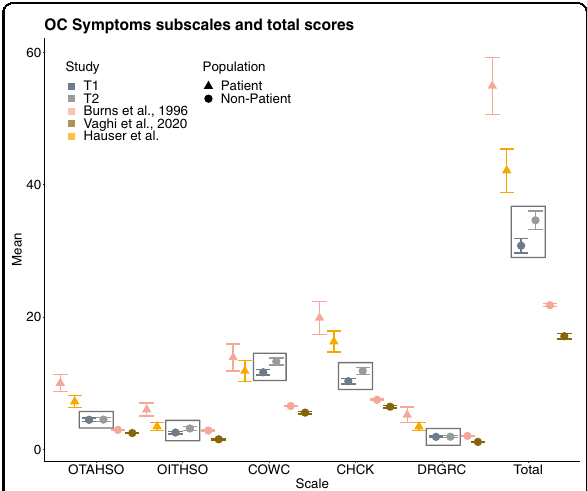
Fig. 2 Average OC symptoms sub- and total scores of the Padua Inventory Washington State University Revision (PI-WSUR) at T1 and T2 in comparison to previous studies. Current study summary statistics are highlighted by surrounding squares (NT1 = 406; NT2 = 296). These are put in context with two pre-pandemic patient samples reported by Burns et al. 35 ( N = 15) displayed as pink triangles and unpublished patient data by Hauser et al. ( N = 31), displayed as yellow triangles. A pre-pandemic non-patient sample reported by Burns et al. 35 ( N = 5010) is shown as pink dots and data from a previously collected young UK public sample reported by Vaghi et al. 53 ( N = 1606) as brown dot. The elevated scores in our sample do not imply that these participants suffer from a clinically relevant disorder, but show that symptoms are elevated across multiple subscales (including some that do not entail Covid-related items, e.g. the CHCK-score) and increased from T1 to T2. OTAHSO Obsessional Thoughts about Harm to Self or Others, OITHSO Obsessional Impulses about Harm to Self or Others, CHCK Checking Compulsions, COWC Contamination Obsessions and Washing Compulsions, DRGRC Dressing and Grooming Compulsions. Data points are means, and error bars represent standard